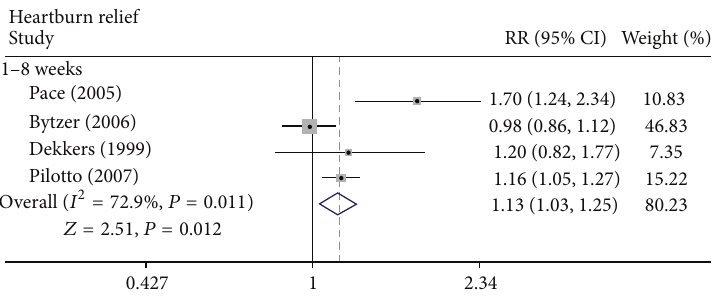
Figure 3: Effect of rabeprazole 20mg once daily versus omeprazole 20 mg once daily on GERD-related heartburn relief. RR: relative risk; CI: confidence